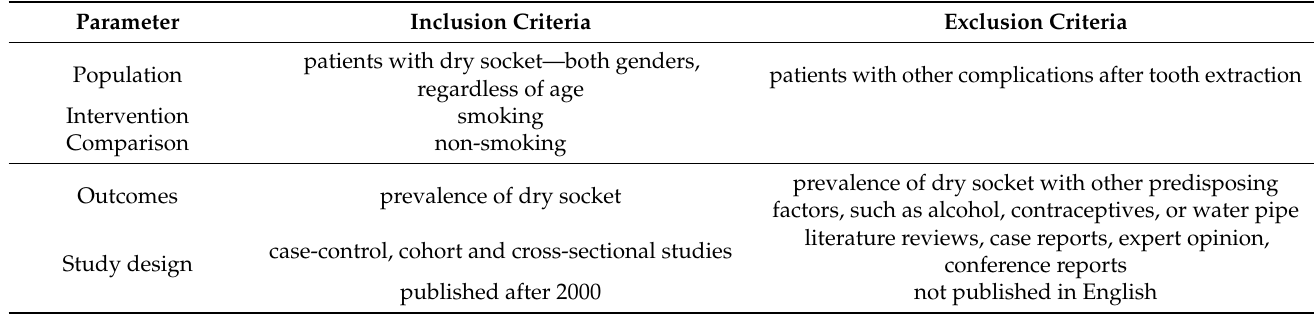
Table 1. Inclusion and exclusion criteria according to the PICOS.